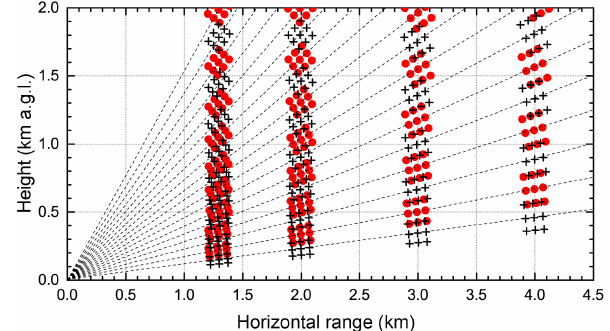
Figure 3. Spatial distribution of the grouping of the measured data used for the noise estimation for a single RHI scan. For each group of nine data points, either black pluses or red dots, the ACF is cal- culated. Different symbols are used for better understanding when the data points are close to each other. Dashed lines indicate each second